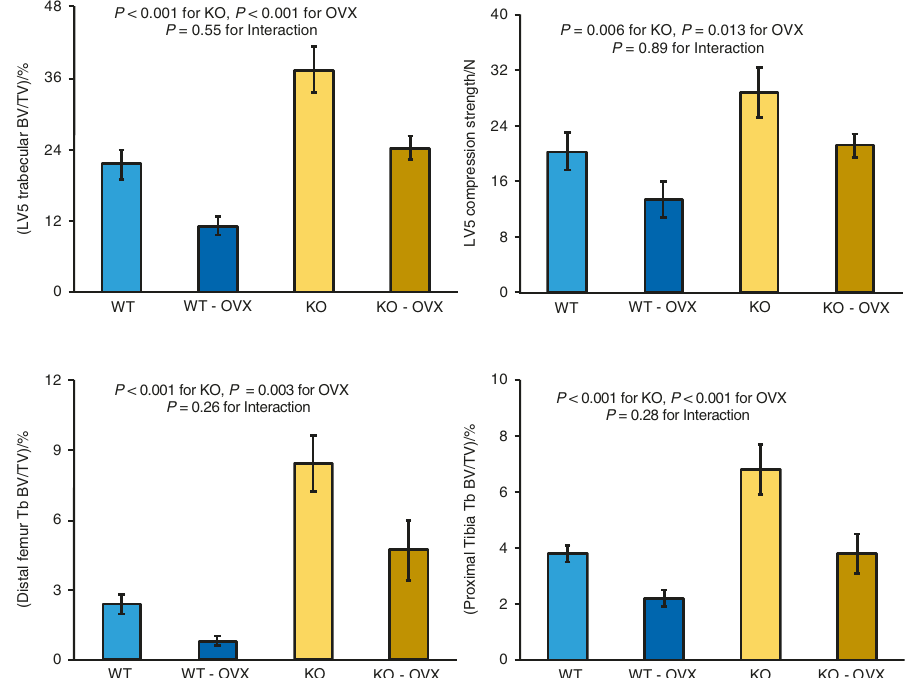
Fig. 3 Effects of Sfpr4 KO and ovariectomy on trabecular bone parameters. Mice underwent ovariectomy or sham surgery at 16 weeks of age and bones were analyzed at 24 weeks of age. Data are means ± SEM for 9 to 11 mice per group, with statistical analysis by two-factor ANOVA